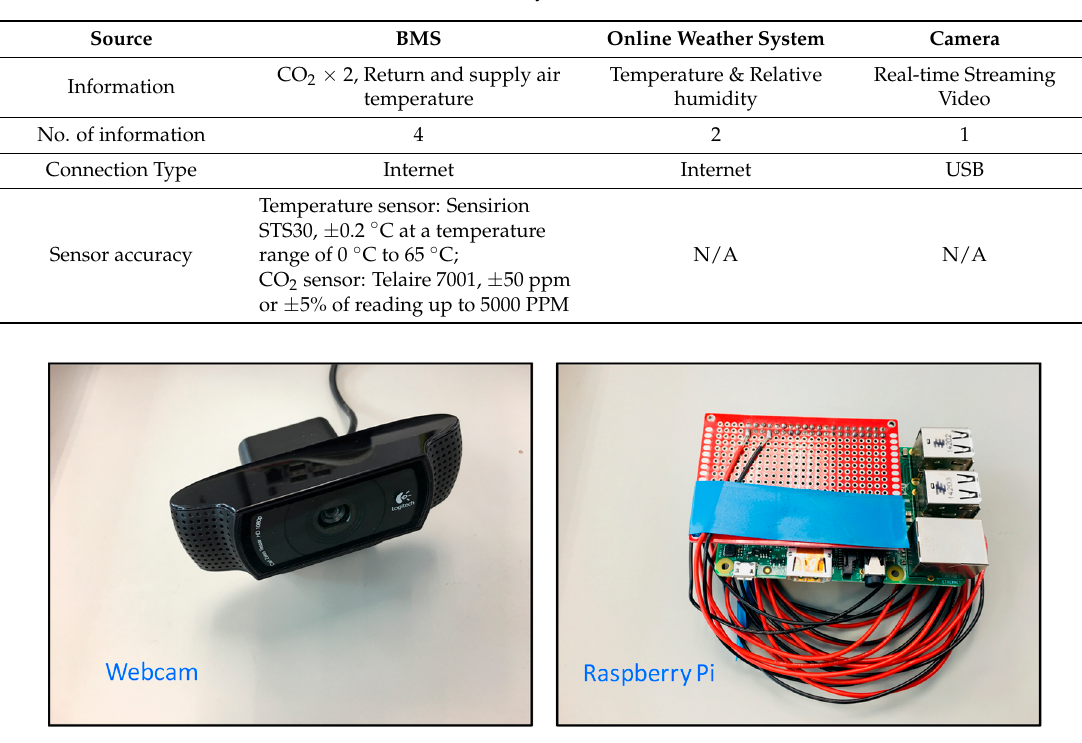
Figure 4. The webcam ( left ) and Raspberry Pi ( right ). Table 4. Summary of data collected.